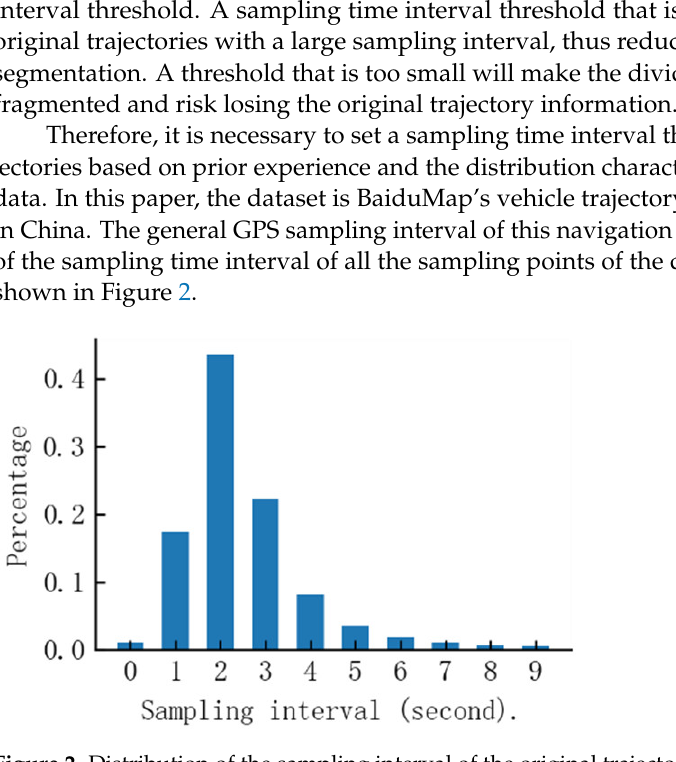
Figure 2. Distribution of the sampling interval of the original trajectory. As can be seen from Figure 2, most of the original trajectory data sampling time interval is less than 5 s; therefore, we set the continuous trajectory sampling time interval threshold τ to 5 s and about 95% of all sampling points. The continuous trajectory amount after segmentation by this threshold is about 10 times the original trajectory